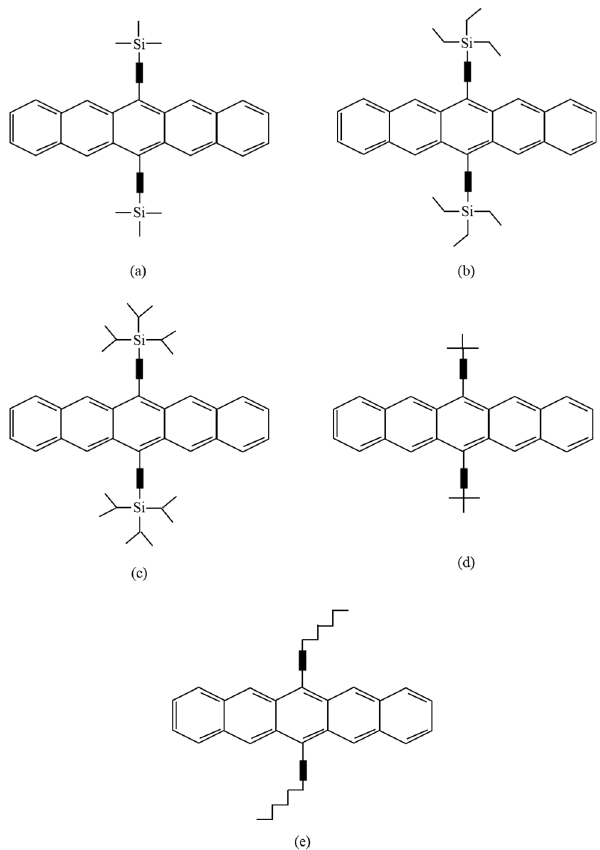
Figure 3. Structures of pentacene derivatives: ( a ) trimethylsilyl (TMS) pentacene; ( b ) triethylsilyl (TES) pentacene; ( c ) triisopropylsilyl (TIPS) pentacene; ( d ) t-butyl pentacene; ( e ) hexyl pentacene.